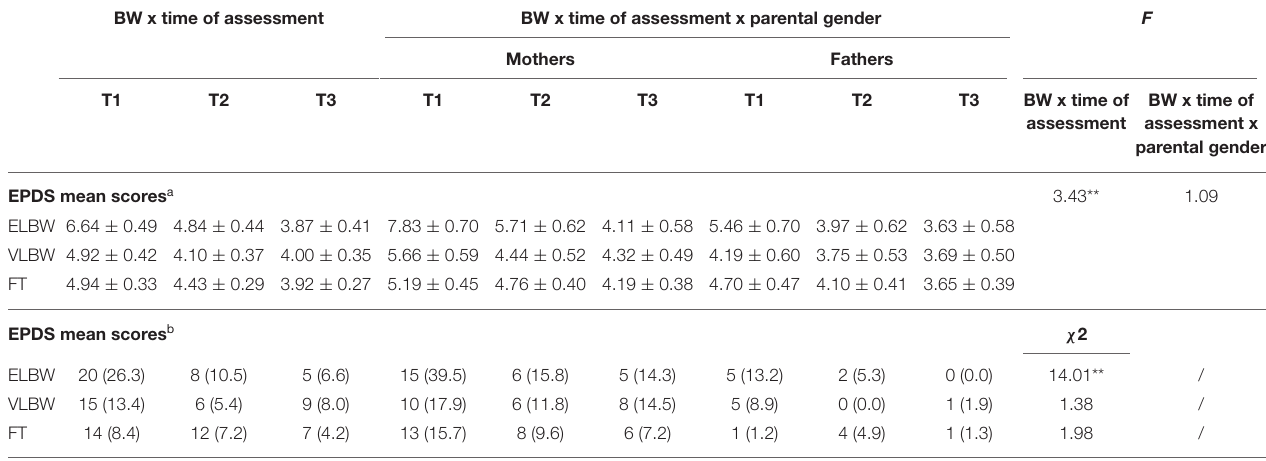
TABLE 2 | EPDS mean and categorical scores according to birth weight, time of assessment and parental gender. BW x time of assessment